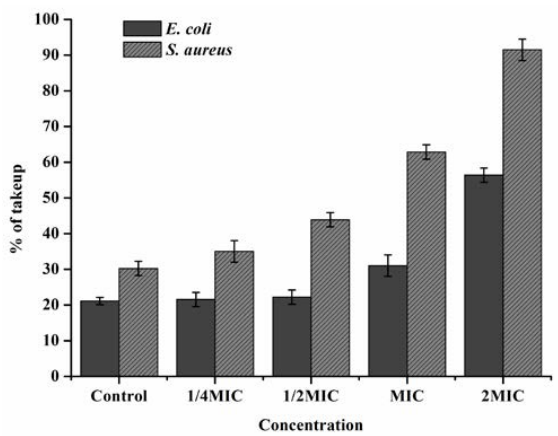
Figure 3. Effect on membrane permeability of E. coil and S. aureus treated with FEO. The concentrations were corresponded to control, 1/4MIC, 1/2MIC, MIC, and 2MIC (MBC). Values of each curve are means ± SD ( n = 3).